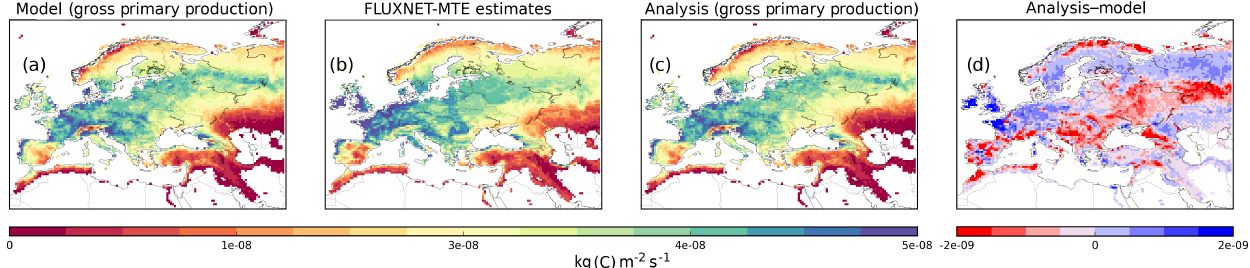
Figure 13. Maps of averaged gross primary production taken over 2000–2011 from (a) the model (i.e open loop), (b) FLUXNET-MTE estimates, (c) the analysis and (d) differences between the analysis and